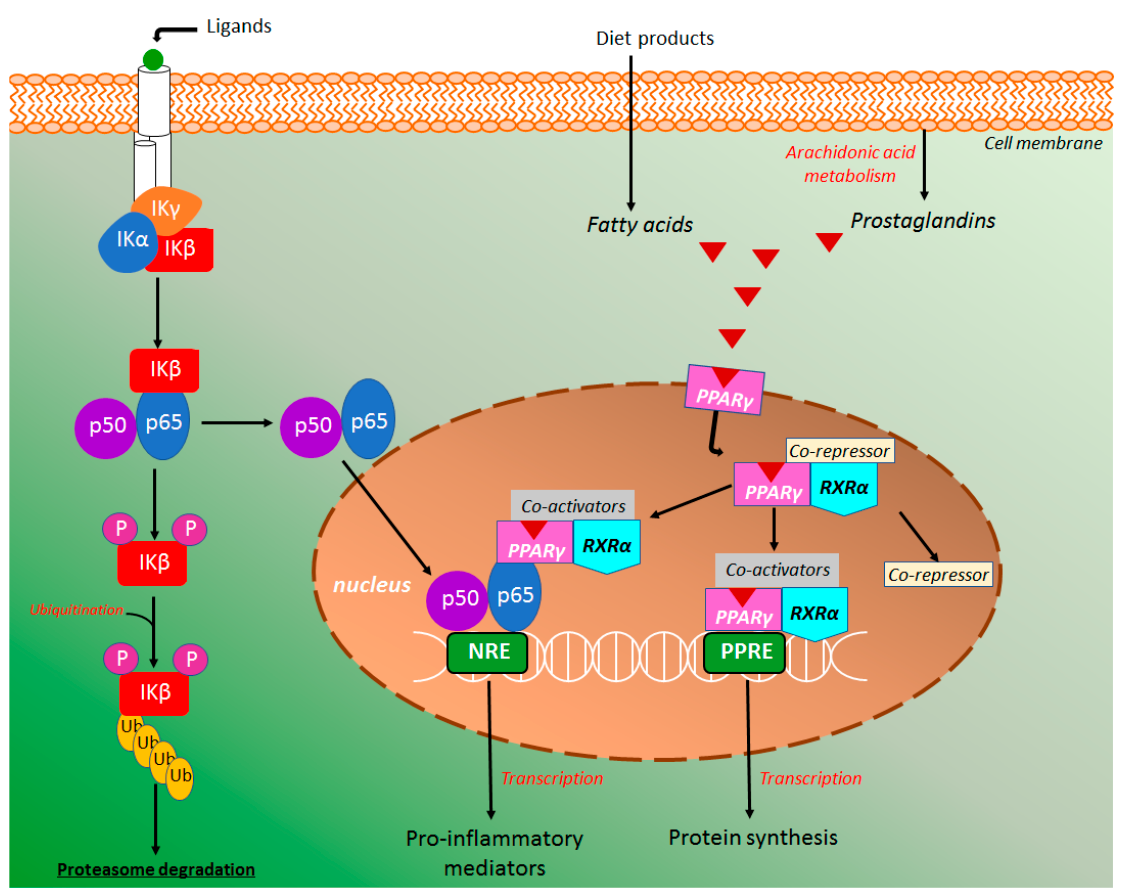
Figure 9. The nuclear factor ‐ kappa b (NF ‐κ B) and peroxisome proliferator ‐ activated receptor gamma (PPAR ‐γ ) signaling pathway in the intestinal inflammatory process. Modulation of NF ‐κ B and PPAR ‐γ signaling pathways was demonstrated by treatment with esculetin, esculin, osthole, and isomeranzin.